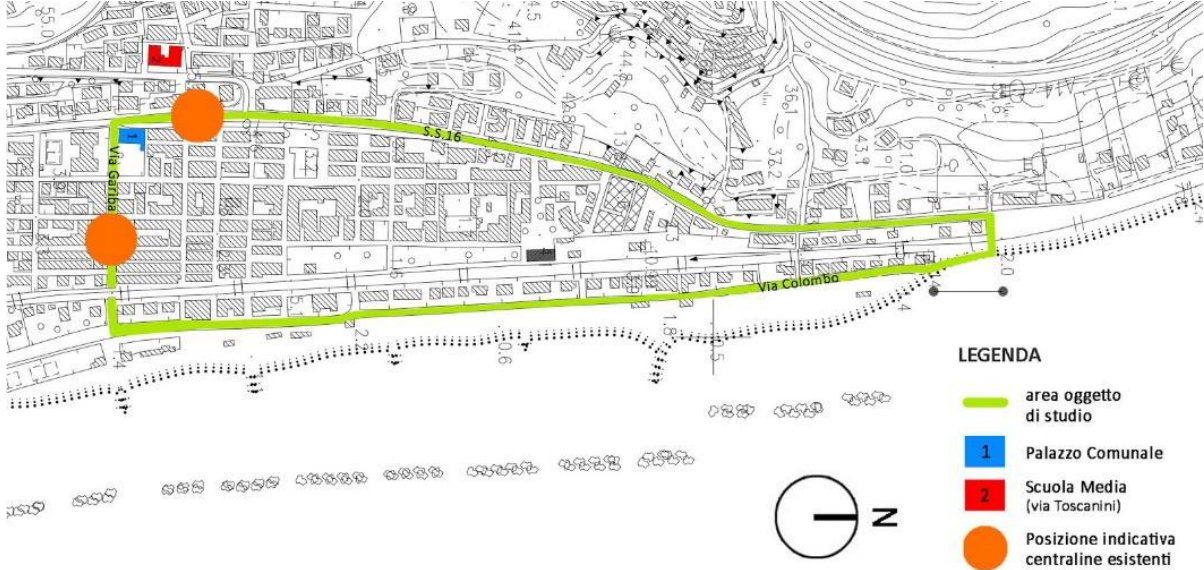
Figure 1: The urban area of Grottammare (Marche,